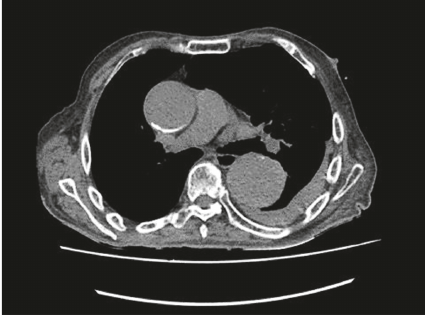
Figure 2: Aortic aneurysm.